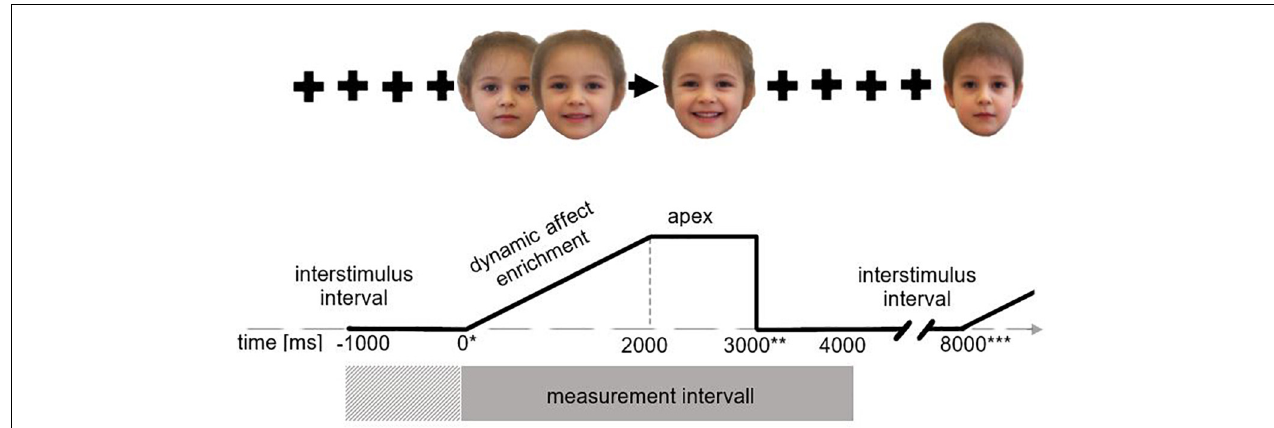
FIGURE 2 | Presentation procedure. *During each trial cycle EMG activity was measured over 4000 ms (gray rectangle) from stimulus onset (indicated by*) with 1000 ms baseline correction (cross-striped rectangle), here shown for the example of a child’s face expressing joy. During the interstimulus interval (5000 ms) a fixation cross was presented from stimulus offset (indicated by **) to end of trial (indicated by ***); the trial begins with a neutral face which dynamically shows an increasing affect expression in the following 2000 ms. After 2000 ms the apex is reached and presented for 1000 ms.